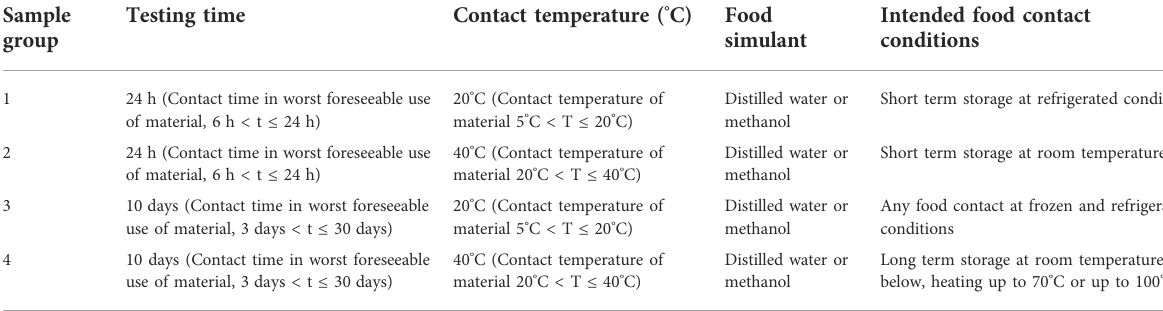
TABLE 2 Overall migration testing performed under standardised testing conditions (European Commission, 2011a).